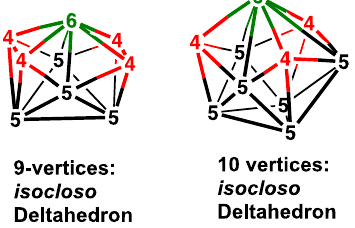
Figure 2. The isocloso deltahedra for the 9- and 10-vertex systems.